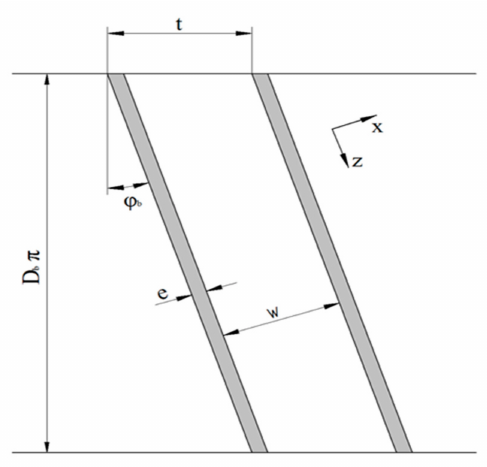
Figure 3. The top view of the unwound screw